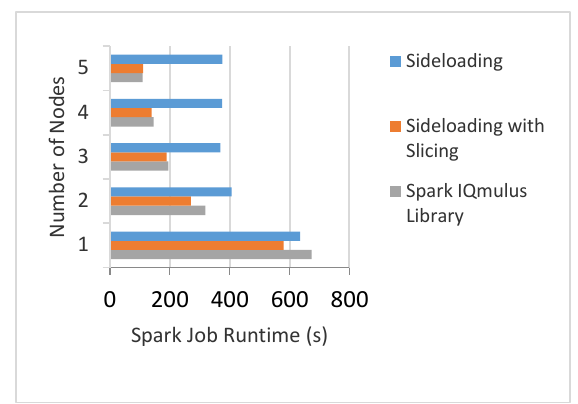
Figure 8: Effect of varying the number of nodes for a fixed sized point